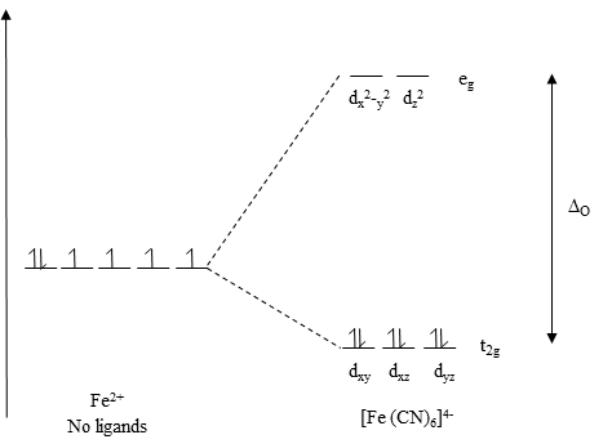
Figure 13. Fe (II) complexes have six electrons in the 5-d orbitals. In the absence of a crystal field (ligands), the orbitals are degenerate. In the presence of ligands (CN − ), the d-orbitals split into e g and t 2g orbitals with an energy difference of ∆ O .